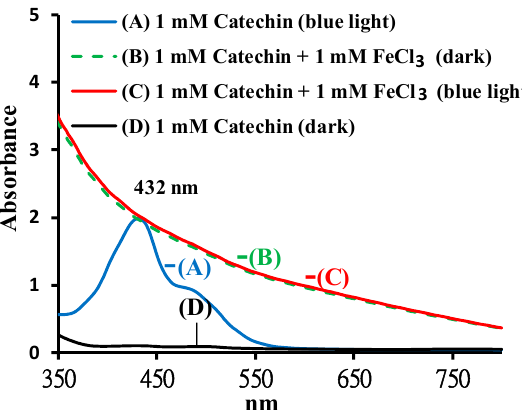
Figure 7. The absorption spectra of 1 mM catechin upon the addition of 1 mM ferric chloride (FeCl 3 ) treated with or without BLI at 20 W/m 2 for 120 min at pH 8.